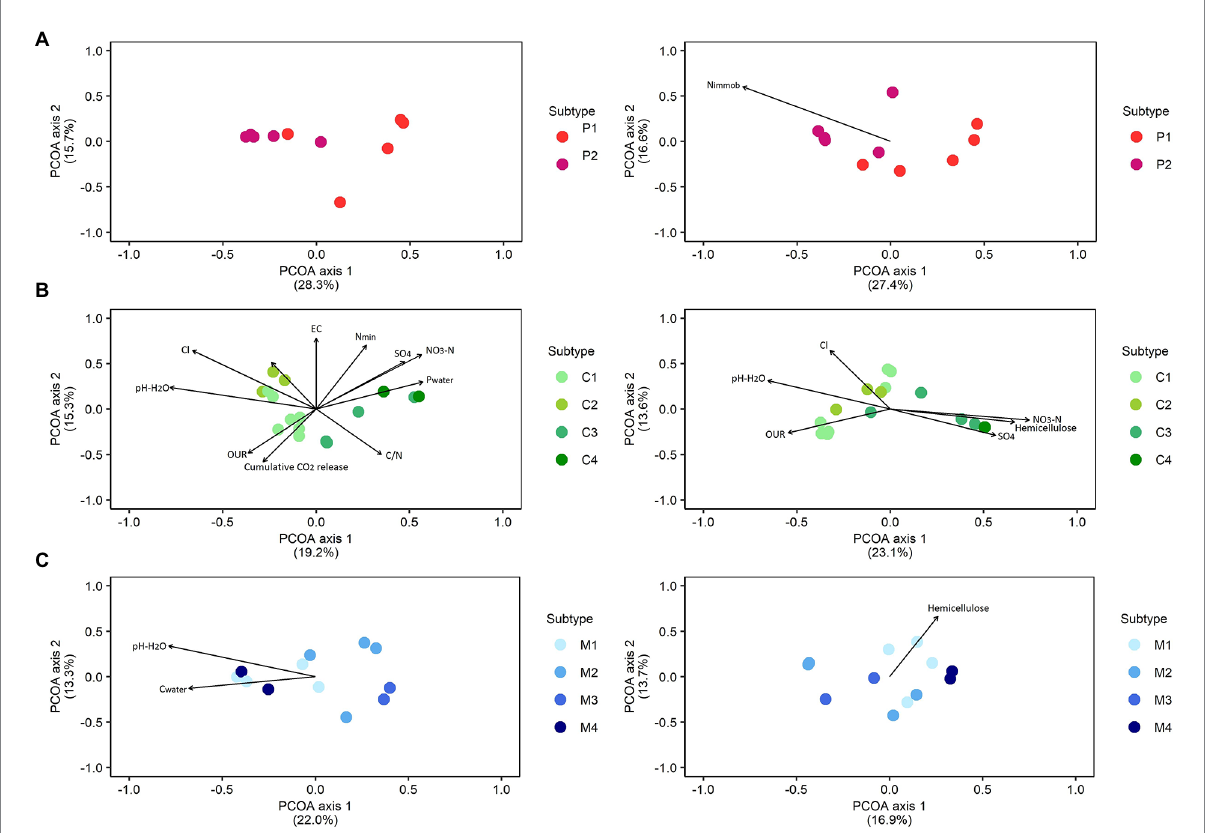
FIGURE 2 Correlations between bacterial and fungal community composition and chemical characteristics. Principal Coordinate Analysis (PCoA) profile of pairwise community dissimilarity (Bray-Curtis) indices of bacterial (16S V3-V4 rRNA gene; left) and fungal (ITS2 gene; right) sequencing data in peat-based substrates (A) , composts (B) , and management residues (C) . Arrows indicate significant correlations between corresponding variables and microbial community composition. The segments are scaled to the r 2 value, so that variables with a longer segment are more strongly correlated with the data than those with a shorter segment. Nimmob = N immobilization; Pwater = water extractable P; Fungi = total biomass fungi; Actinomycetes = total biomass actinomycetes; Gram – bact. = total biomass Gram-negative bacteria; Gram + bact. = total biomass of Gram-positive bacteria; Non-specific bact. = total biomass of non-specific bacteria. P1 = pure peat-based substrates ( n = 5); P2 = limed peat-based substrates ( n = 5); C1 = green composts (n = 7); C2 = VFG composts ( n = 3); C3 = woody composts ( n = 4); C4 = peat composts ( n = 2); M1 = grass clippings ( n = 4); M2 = chopped heath ( n = 4); M3 = forest sods ( n = 2); M4 = woody fractions of composts ( n =